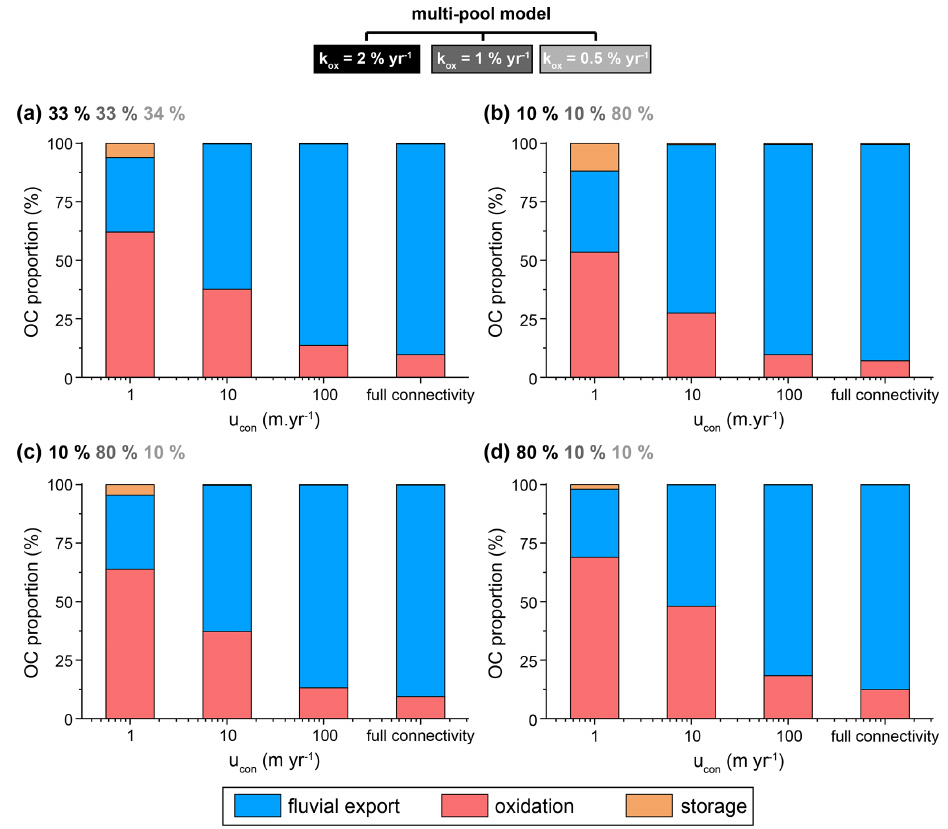
Figure 7. Histograms showing the fate of the landslide-mobilized OC at the end of a seismic cycle with a duration of 270 years partitioned between fluvial export, oxidation and hillslope storage. These results have been computed for different connection velocities with a multi-pool model composed of three pools with oxidation constants k ox = 2%yr − 1 , 1%yr − 1 and 0.5%yr − 1 . Panels (a) – (d) show model outcomes with different proportions of OC in the three modeled pools, as indicated by the greyscale text: (a) equal distribution between pools, (b) dominance of the low-reactivity pool, (c) dominance of the intermediate-reactivity pool and (d) dominance of the high-reactivity